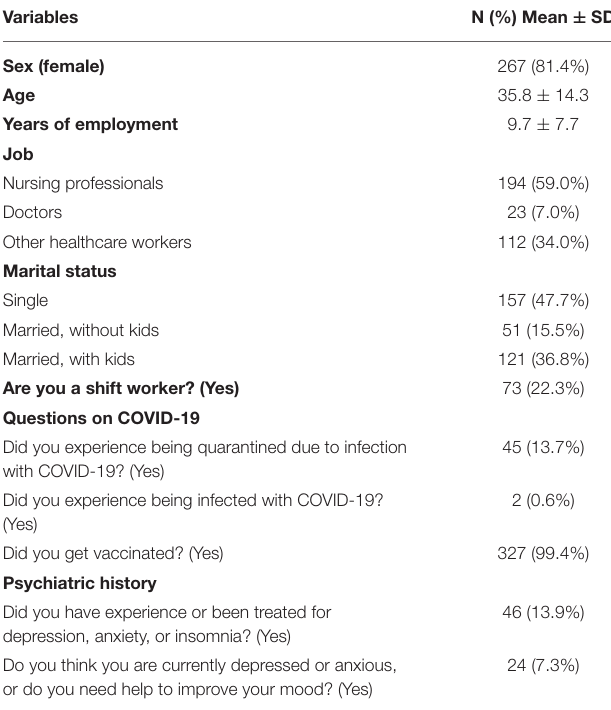
TABLE 1 | Clinical characteristics of participants ( N =